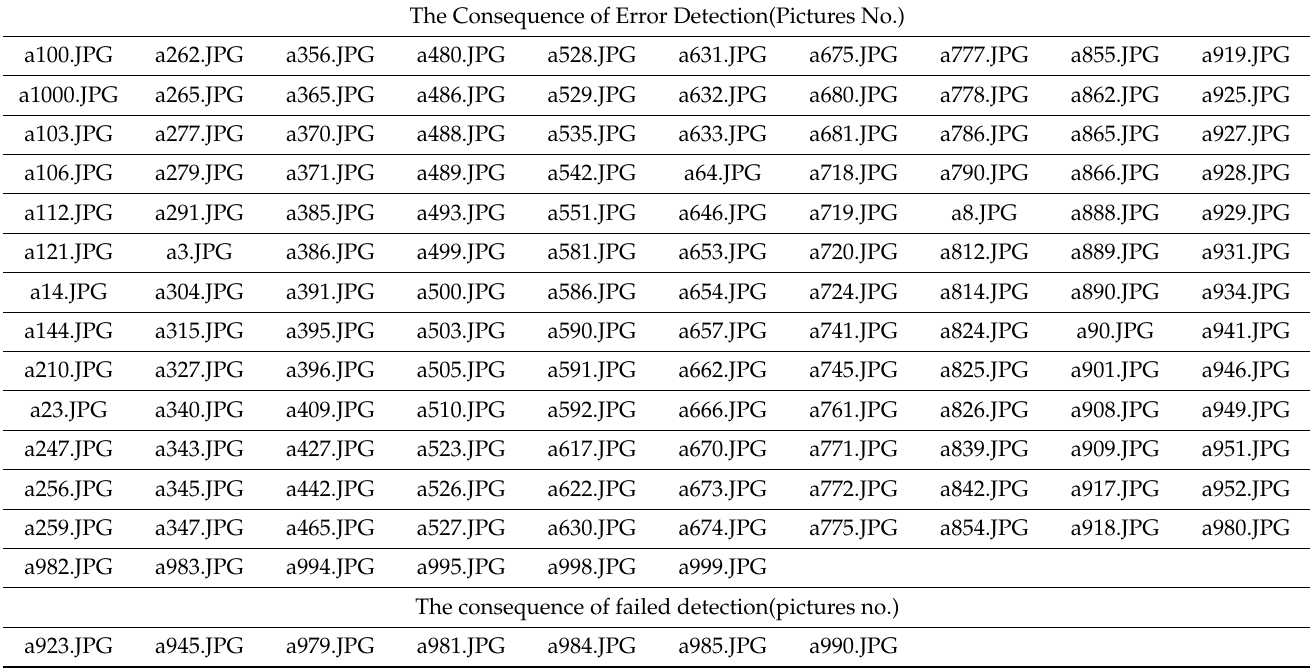
Table A1. The Consequence of Error Detection and Failed